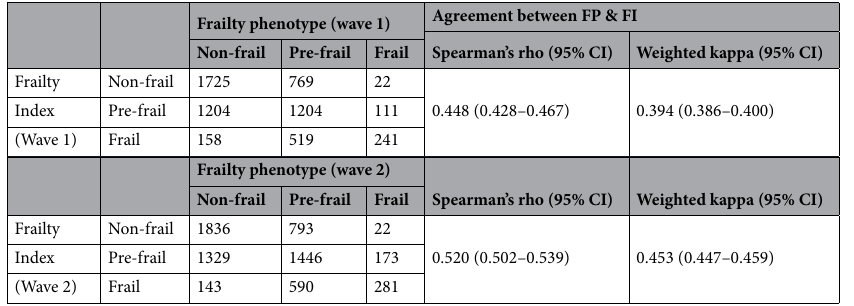
Table 2. Agreement between classification of individuals with frailty using the frailty phenotype and frailty index at Waves 1 and 2.